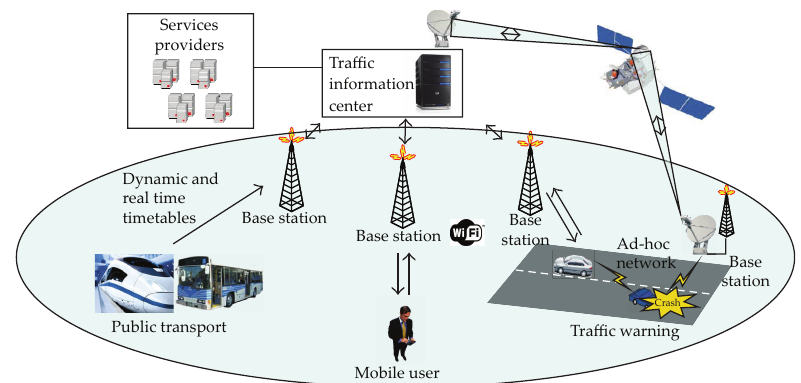
Figure 4: Carlink platform